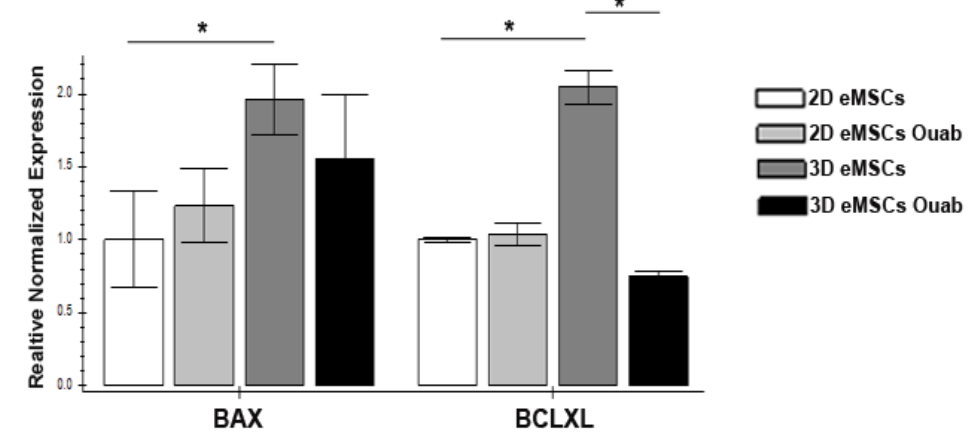
Figure 4. Ouabain-induced gene expression profiles in 2D and 3D eMSCs. Expression. Pro-apoptotic ( BAX ) and anti-apoptotic ( BCLXL ) genes in 2D and 3D eMSCs, controled and exposed to 1 µM ouabain (24 h after the ouabain treatment). Data are shown as mean ± SD (n = 3). * p < 0.05 the control 3D vs. control 2D eMSCs or the control 3D vs. the ouabain-treated 3D eMSCs.